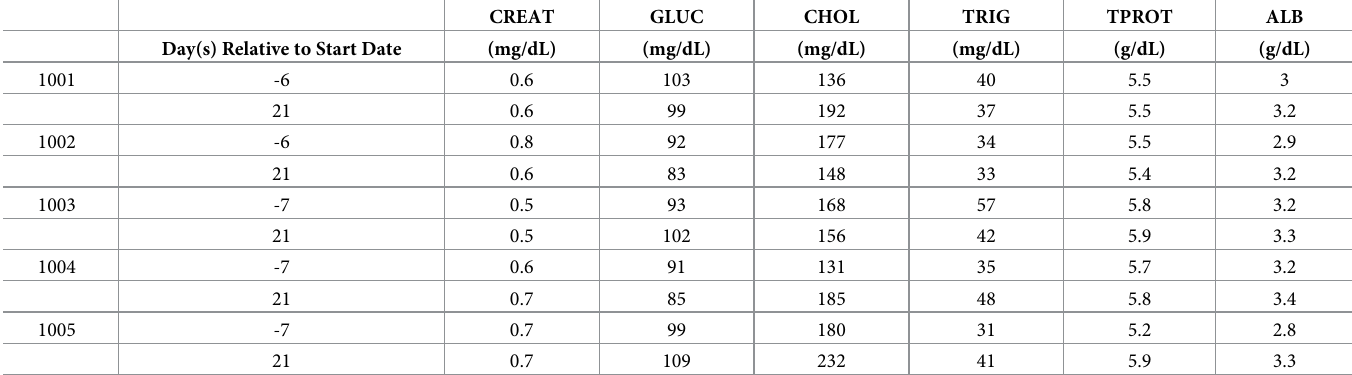
Table 5. Biochemistry reporting for each animal for CREAT, GLUC, CHOL, TRIG, TPROT, and ALB. CREAT GLUC